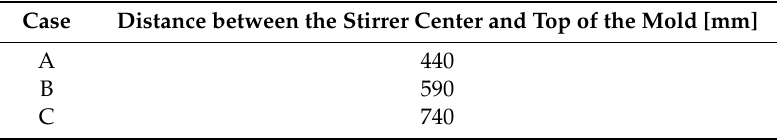
Table 4. Di ff erent schemes for installation position of Table 4. Different schemes for installation position of stirrer.